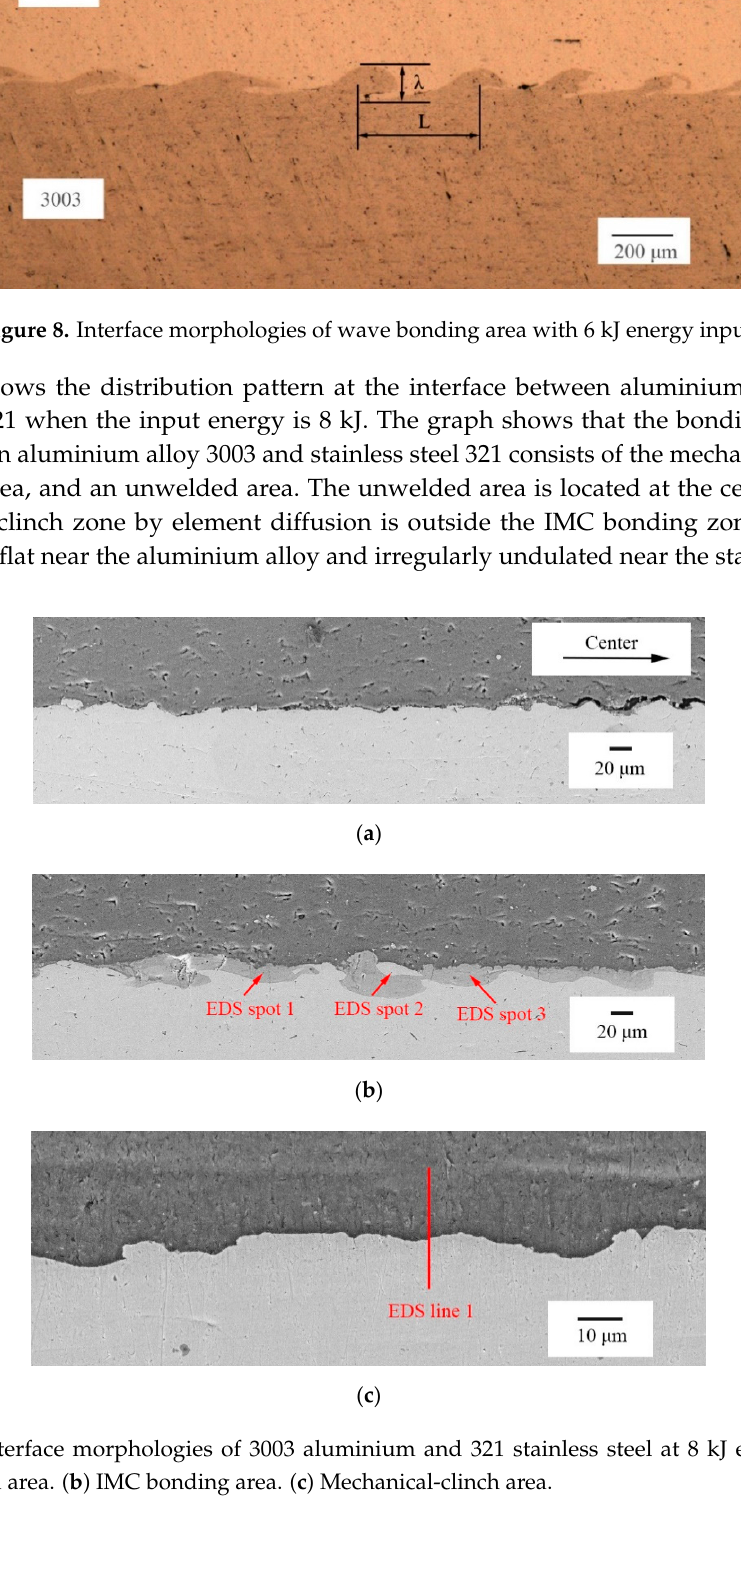
Figure 7. Interface morphologies of flyer and interlayer at 6 kJ, 8 kJ, 10 kJ, and 12 kJ input energies. The distance between the crest height, λ , and the distance, L , between two waves are given in Figure 8. The crest height and inter-wave interval increase with the input energy increase. The crest heights are 96, 116, 120, and 124 μ m, whereas the inter-wave intervals are 332, 358, 471, and 493 μ m.